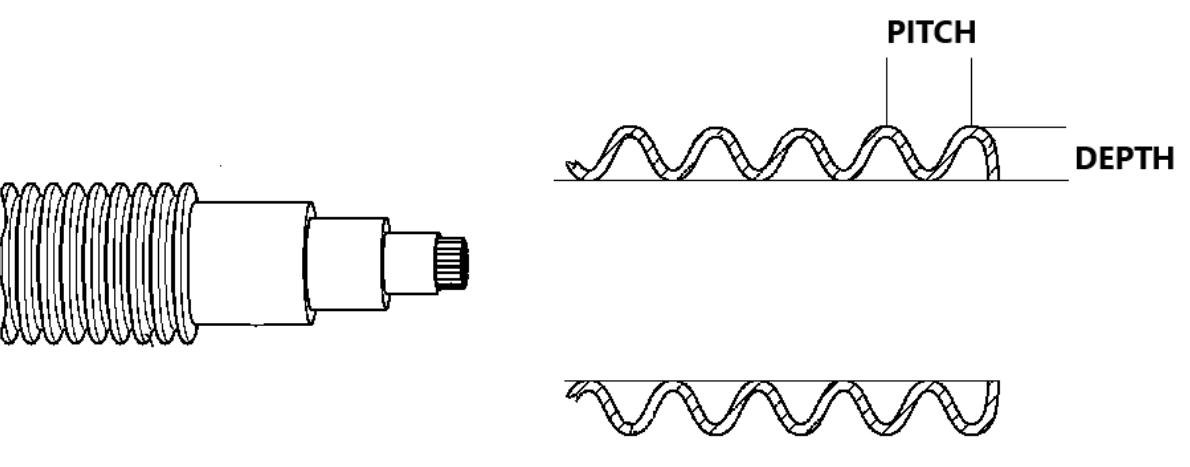
Figure 5. Sketch of a cable and corrugated tape.